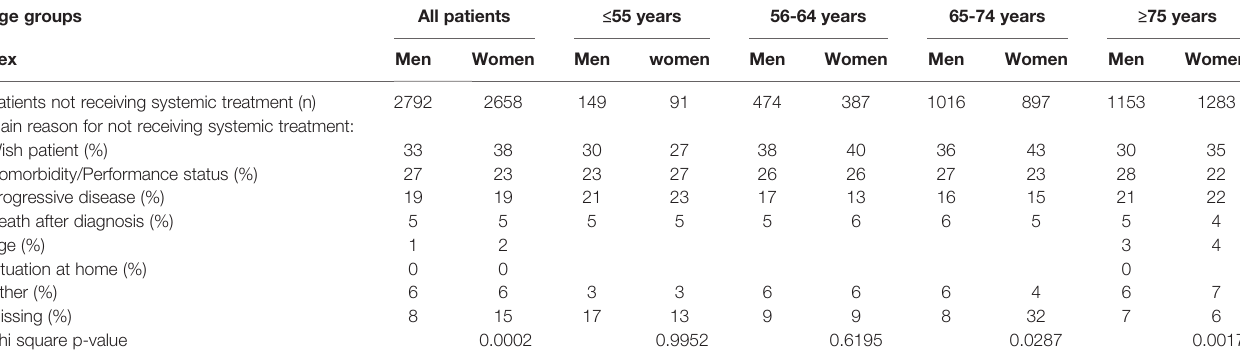
TABLE 2 | Reasons for no administration of systemic treatment in women and men with metastatic pancreatic cancer per age group. Age groups All patients